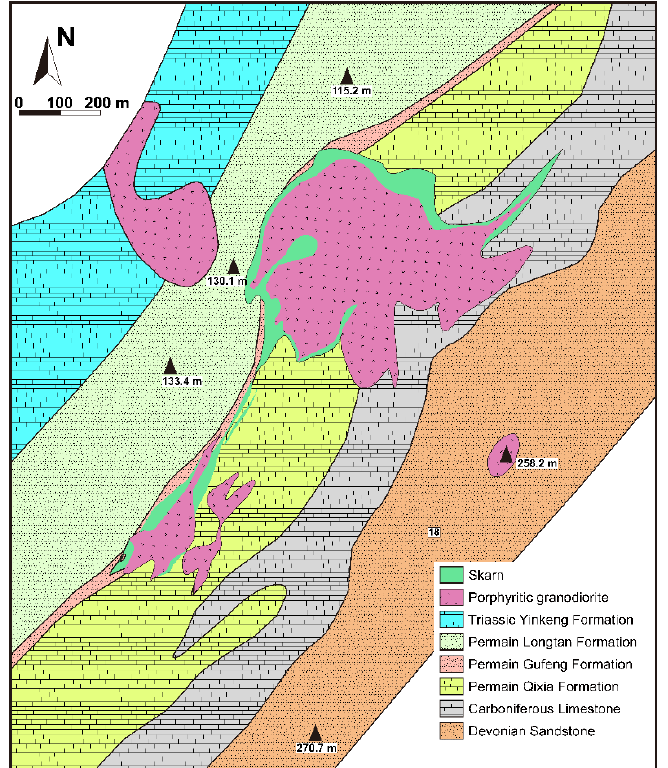
Figure 3. Geological map of Magushan Cu-Mo deposit. (Modified from Bian. [19], Ye. [43], and Hong et al.